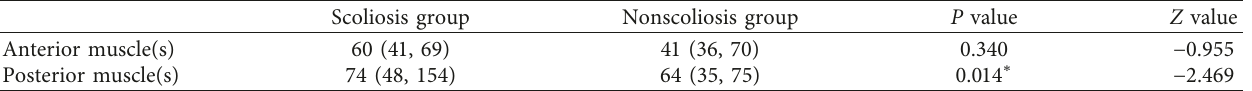
Table 4: Descriptive statistics of strength of the core muscles around the lumbar spine in both groups.